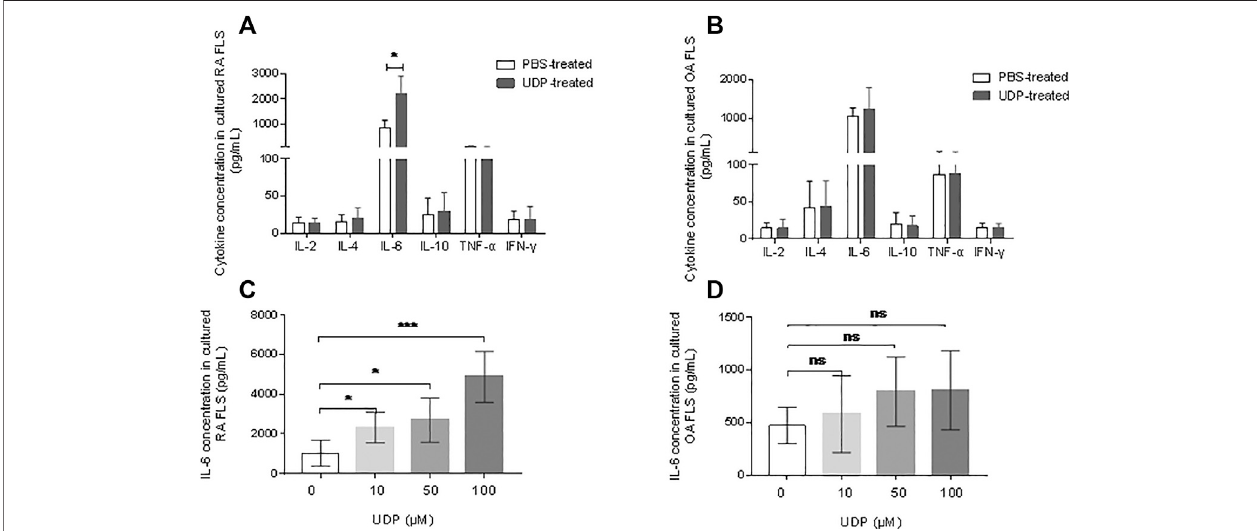
FIGURE 4 | The effect of UDP on cytokine secretion of synovial fi broblast cells. Cytokine secretion in cultured medium of RA (A) or OA (B) synovial fi broblast cells ( n (cid:1) 5 for each disease) was assessed using a fl ow cytometric bead assay. IL-6 secretion in the culture medium of RA (C) or (D) synovial fi broblast cells ( n (cid:1) 5 for each disease) was also assessed using ELISA. These experiments were repeated three times. FLS: synovial fi broblast cells. * p < 0.05, ** p < 0.01 and *** p <